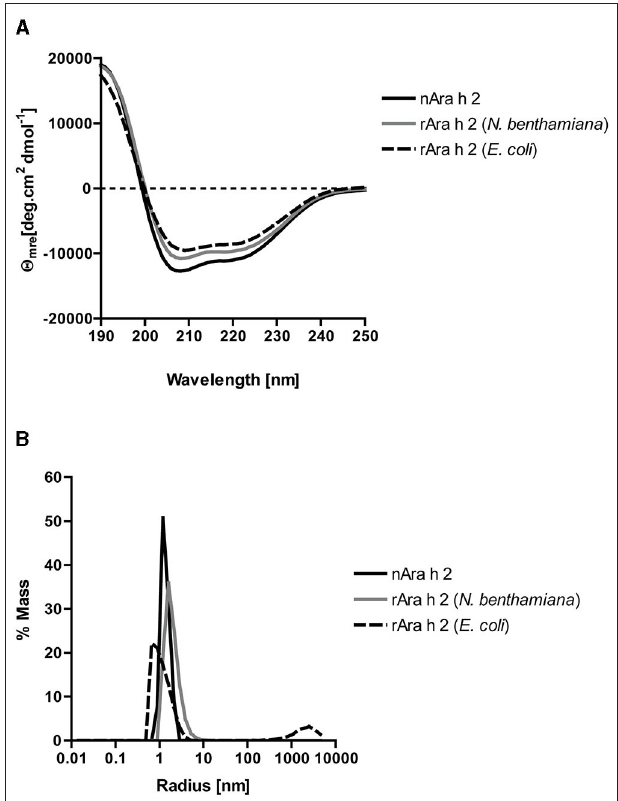
FIGURE 2 | Biochemical characterization of nAra h 2, rAra h 2 ( N. benthamiana ), and rAra h 2 ( E. coli) . (A) Circular dichroism spectra showing double minima at 208 and 222nm indicated exclusively alpha helical content for all three proteins. (B) Dynamic light scattering measured monomeric states for all three proteins, except for rAra h 2 from E. coli , which contained 1% aggregates.